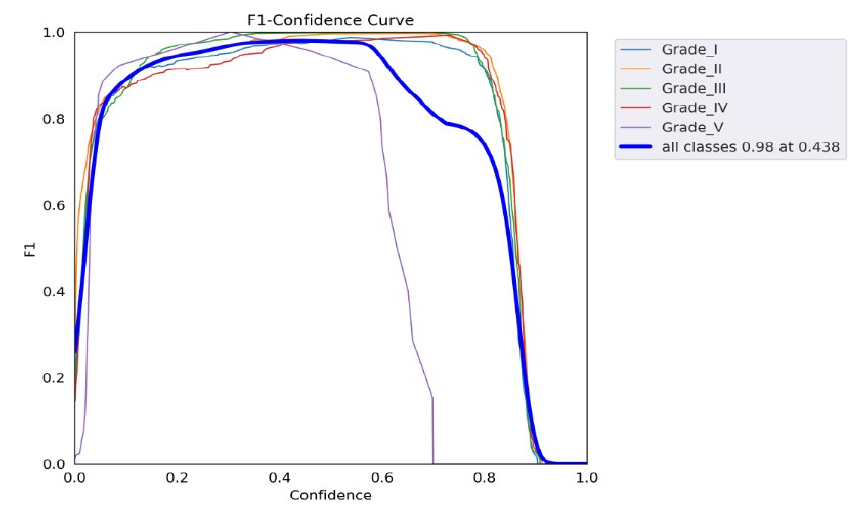
Figure 9. F1 score graph showing the relationship between F1 and the confidence curve.